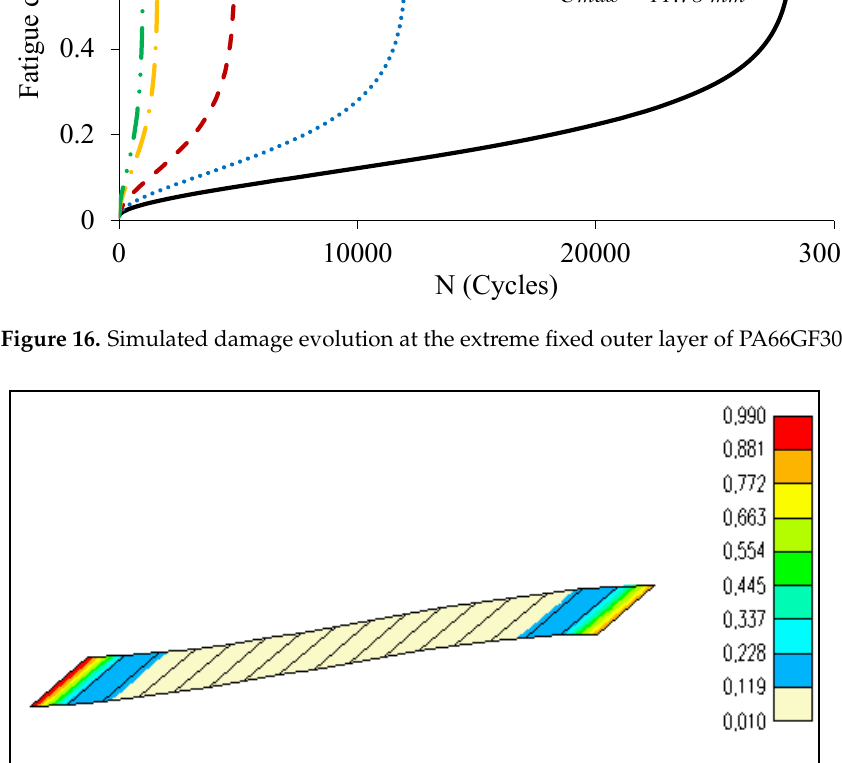
Figure 16. Simulated damage evolution at the extreme fi xed outer layer of PA66GF30 specimens.